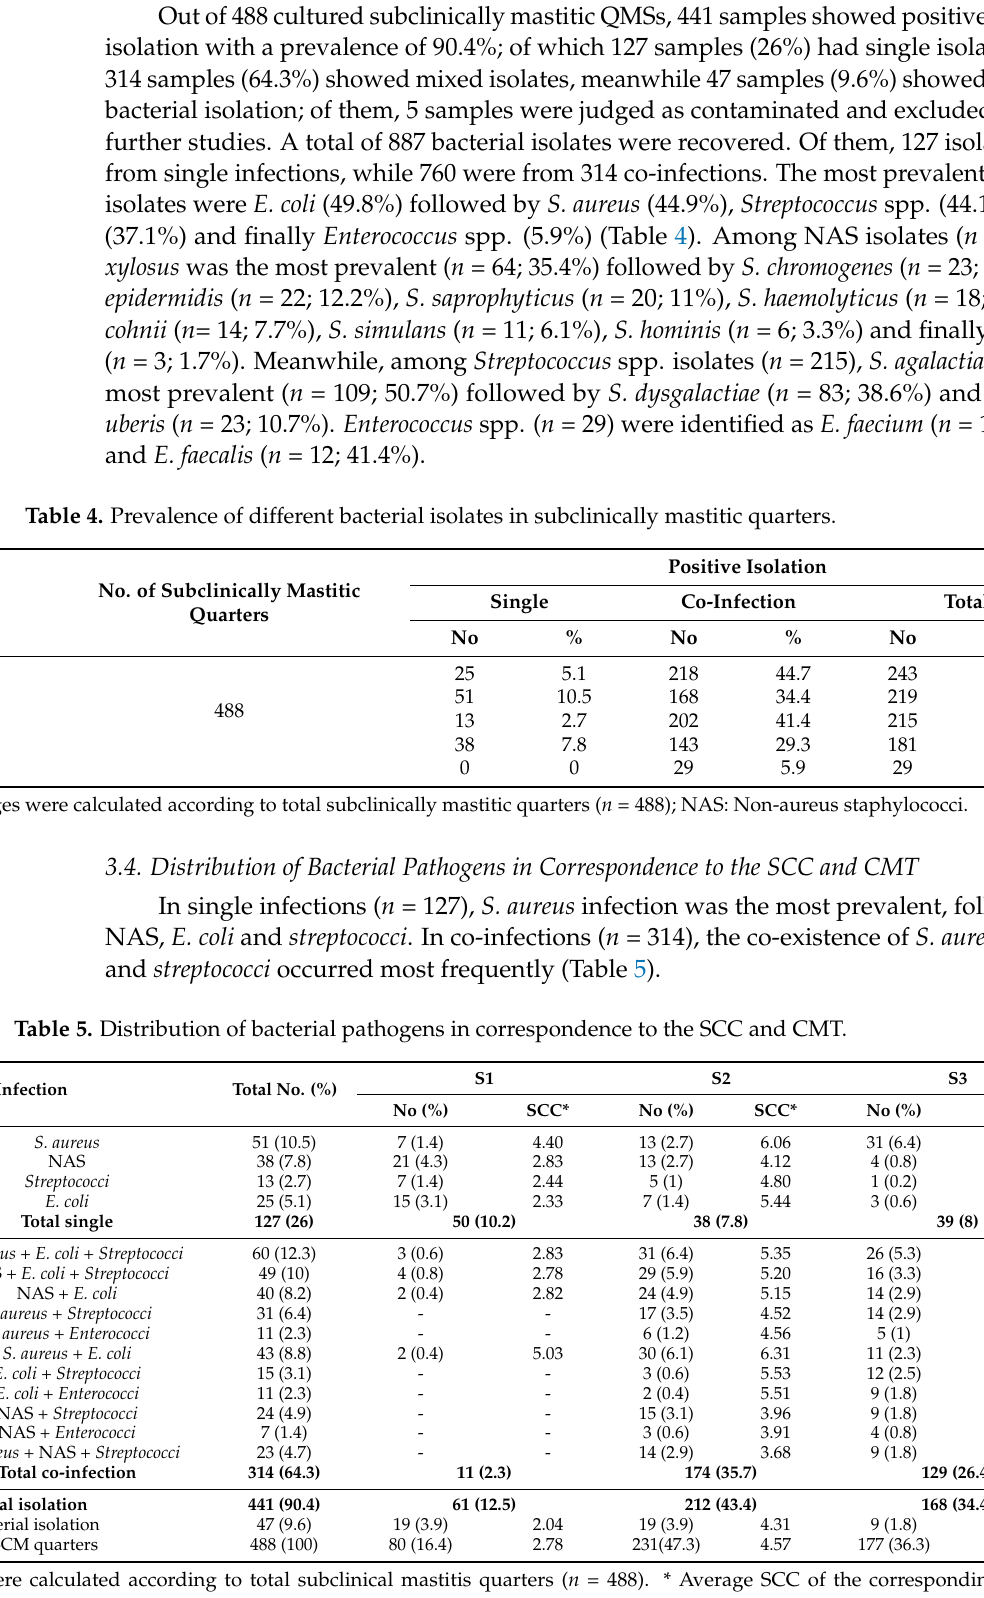
Table 4. Prevalence of different bacterial isolates in subclinically mastitic quarters.